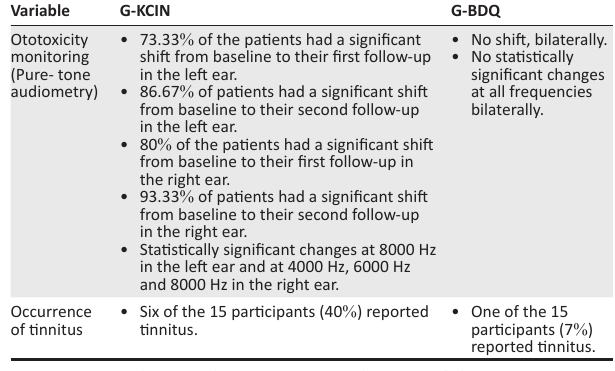
FIGURE 3: Mean left pure-tone audiometry results (in decibel) for the bedaquiline treatment, at the three different sessions ( n = 15).